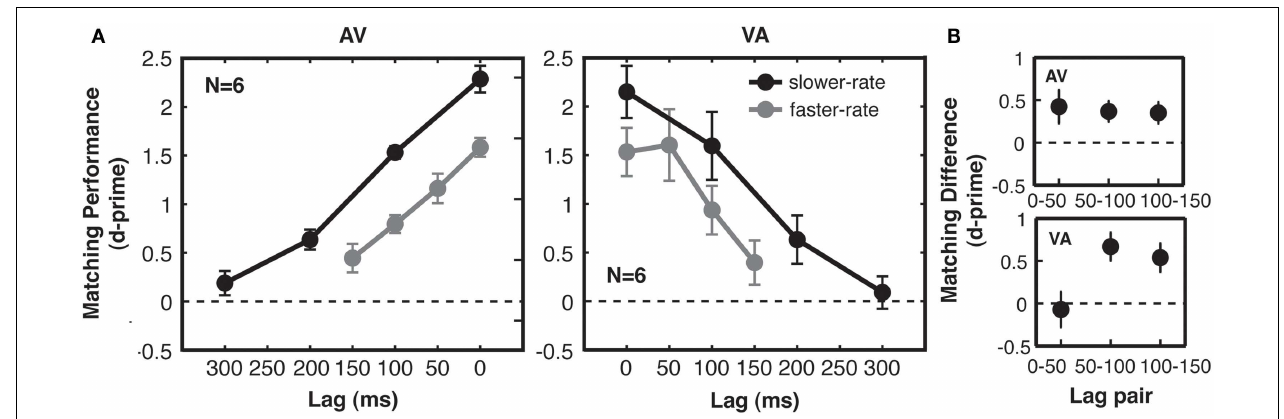
time lag on performance for the two types of trials was similar. For slower-rate trials, performance was similar when auditory streams preceded matching visual streams (AV subjects, left) and when auditory streams followed matching visual streams (VA subjects, right). (B) Quantification of modality order effect for faster-rate trials. Differences in matching performance between adjacent lag pairs were taken for each subject. All error bars give standard error of the mean between